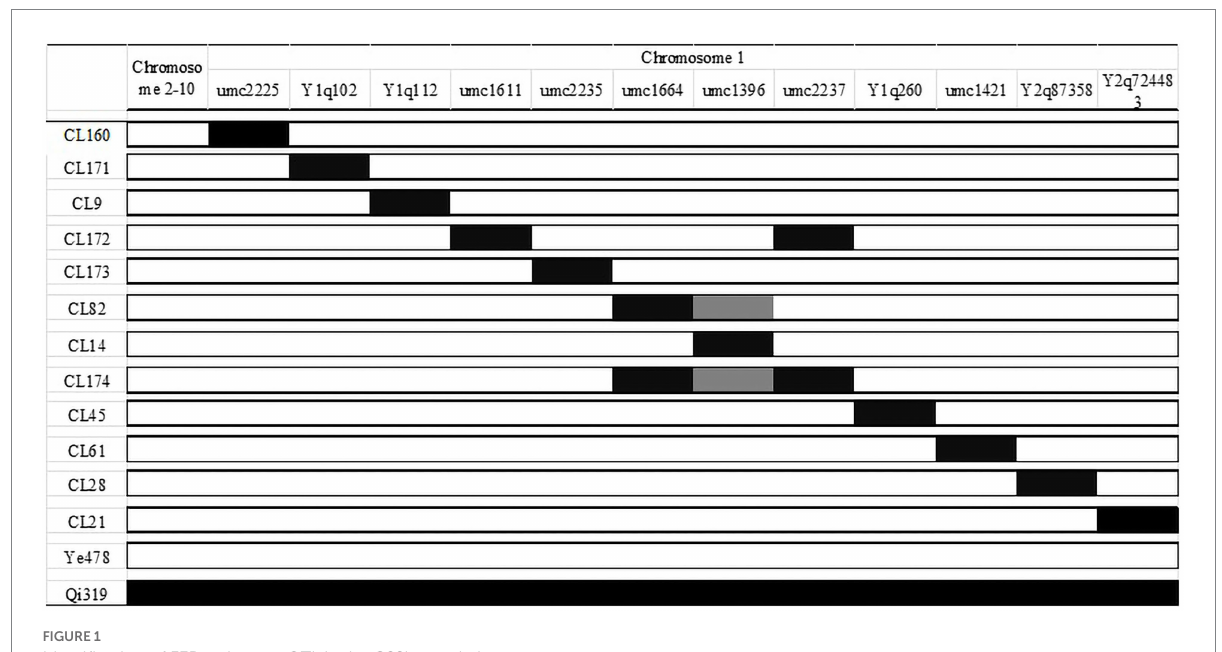
FIGURE 1 Identification of FER resistance QTL in the CSSL